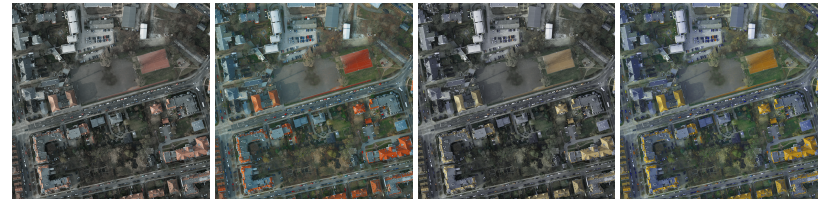
Figure 1. DA-II Sample